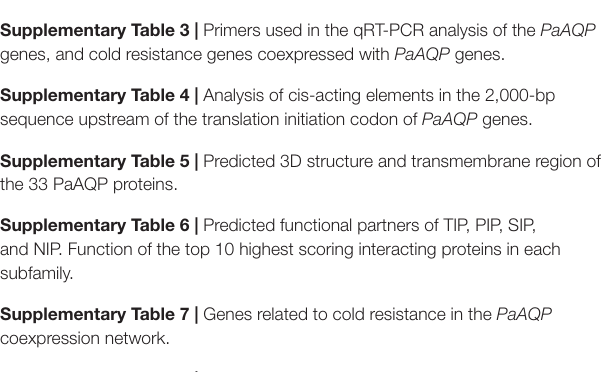
Supplementary Table 2 | The coding regions of WRKY6 , TSPO , and ATHATPLC1G can interact with PaAQP genes. Supplementary Table 3 | Primers used in the qRT-PCR analysis of the PaAQP genes, and cold resistance genes coexpressed with PaAQP genes. Supplementary Table 5 | Predicted 3D structure and transmembrane region of the 33 PaAQP proteins.